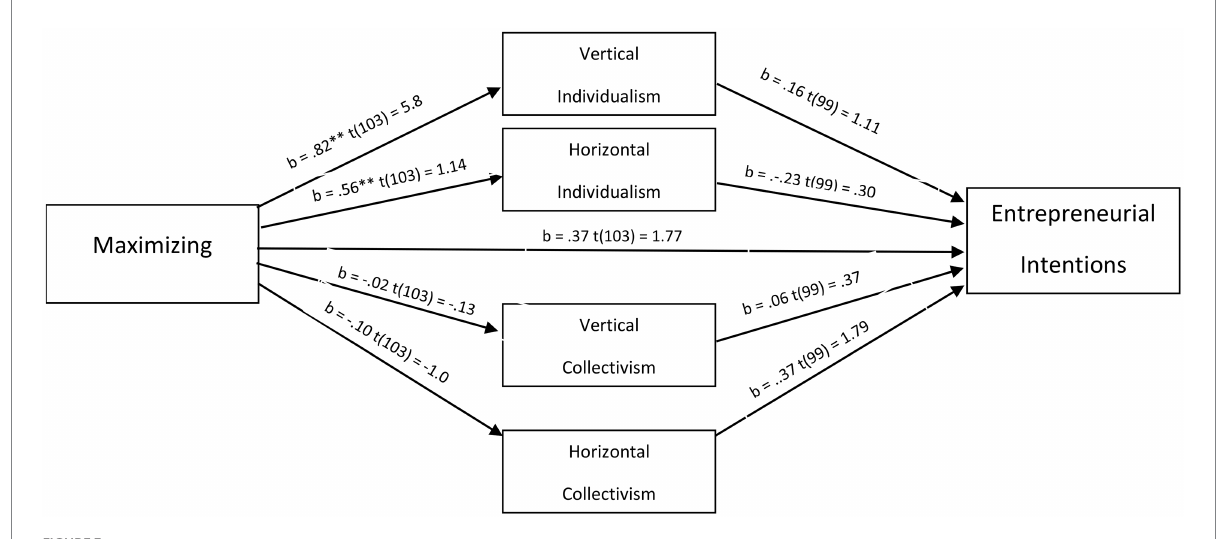
FIGURE 3 Mediation results of study